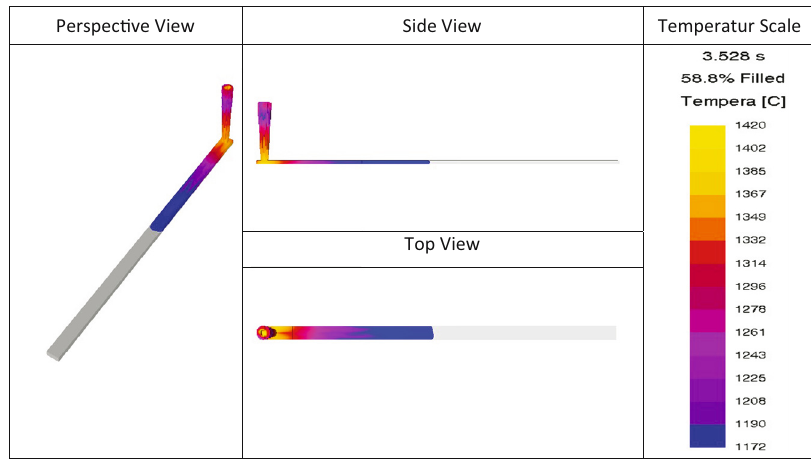
Figure 2: Sample image taken from FlowCast fi lling modeling software.